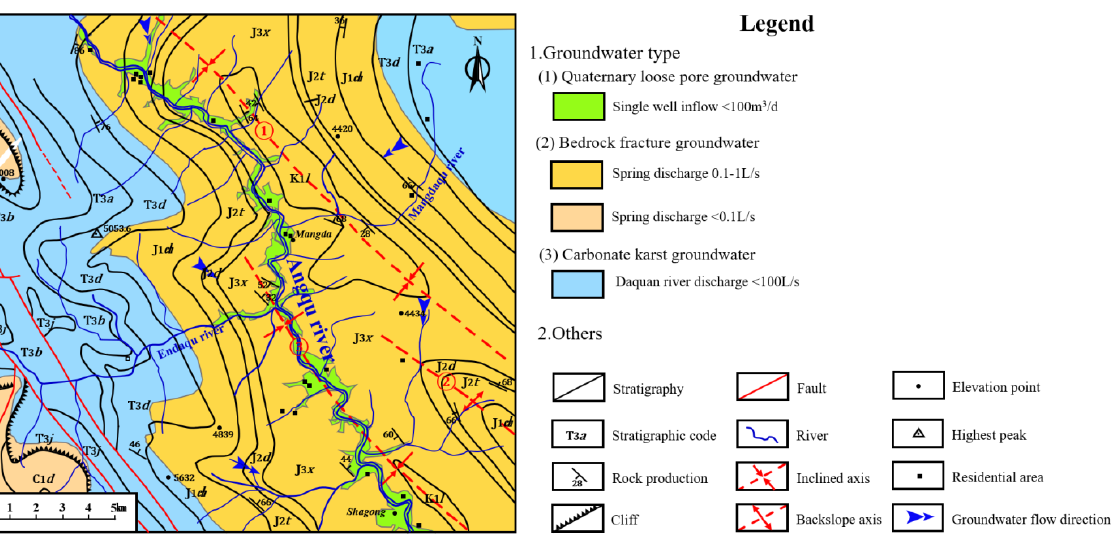
Figure 1. Hydrogeological map of study